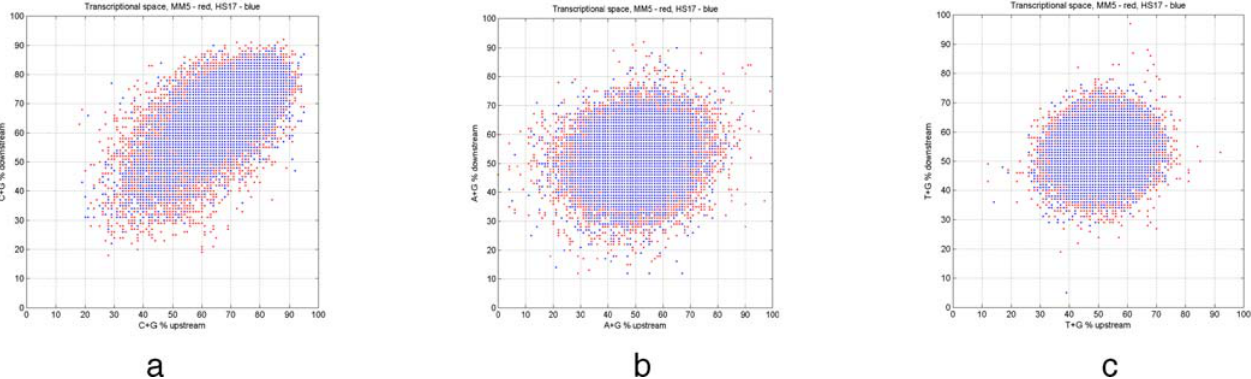
Figure 1. Transcription Initiation Domains for Mouse and Human Distribution of mouse (red) TSSs overlapped by human (blue) TSSs based on (A) C þ G content, (B) A þ G content, and (C) T þ G content. Nucleotide content is determined for upstream [ (cid:2) 100, (cid:2) 1] and downstream [ þ 1, þ 100] regions relative to the TSS. The distribution of TSS locations is more or less random when viewed in terms of A þ G content (B) or T þ G content (C). Strong polarization of distributions is evident only in the G þ C case (A). DOI: 10.1371/journal.pgen.0020054.g001 PLoS Genetics |